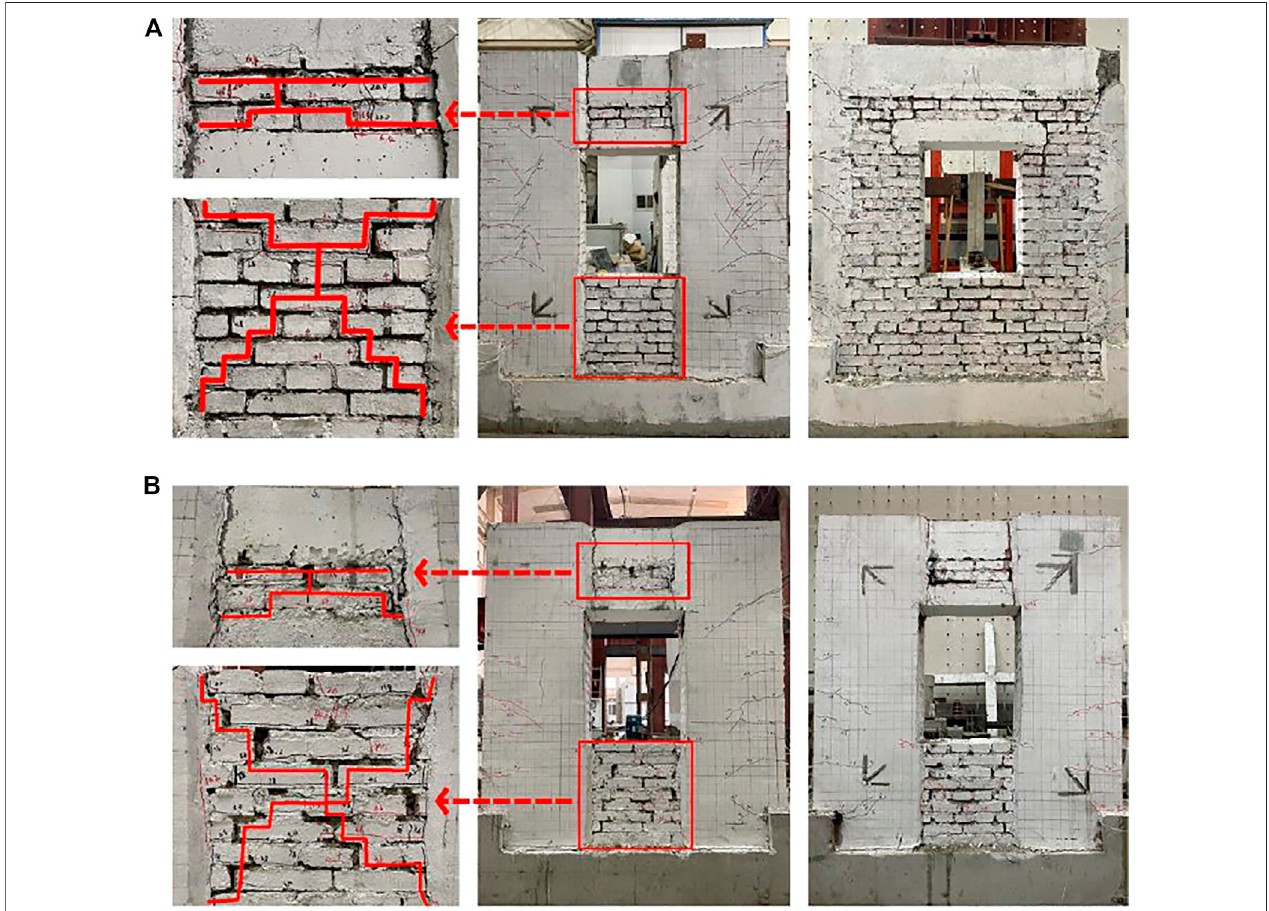
FIGURE 8 | Failure mode and crack pattern for SPRW-5 and DPRW-6 at ultimate displacement (A) SPRW-5 (B) DPRW-6.